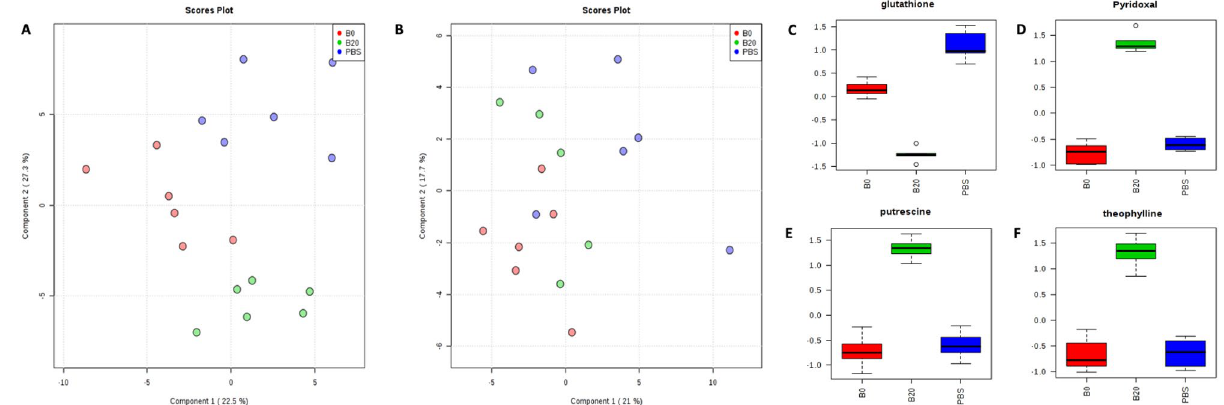
Figure 4. Host metabolic profile difference in both female and male mice and the most contributed metabolites in plasma samples of female mice. The PLS-DA plots showed the metabolic profile of B0, B20, and PBS groups for females ( A ) and males ( B ). Metabolites that contributed most to the significantly different clustering of female mice based on their p values were shown in ( C – F